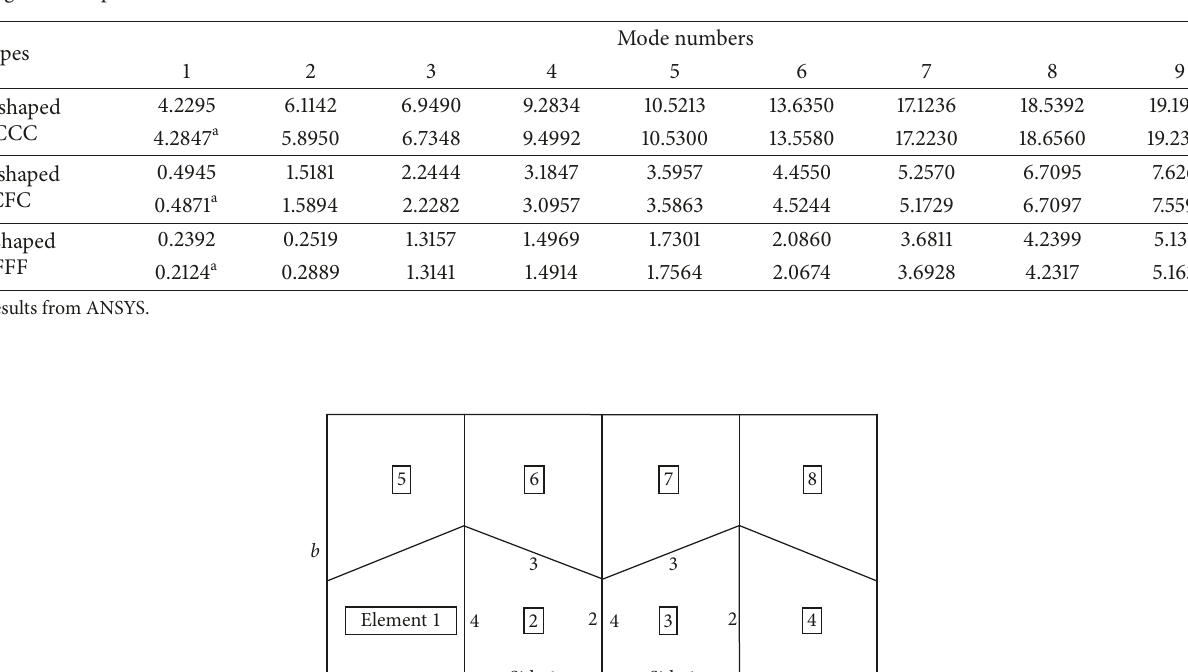
Table 2: Natural frequencies of rectangular plates with several classical boundary conditions and irregular T-shaped, irregular L-shaped, and irregular I-shaped cracks.